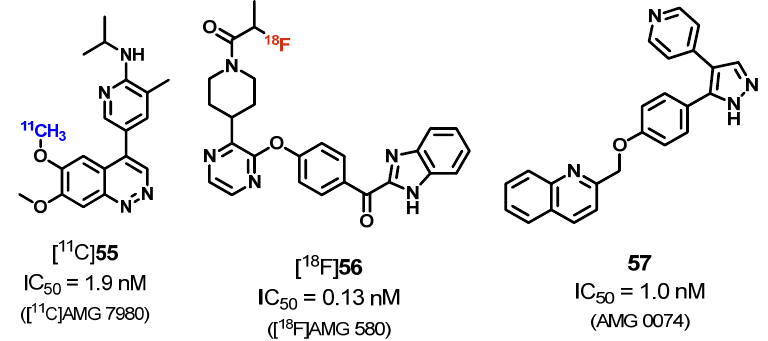
Figure 12. Molecular structures of 11 C- or 18 F-labeled PDE10A radioligands for PET and the PDE10A